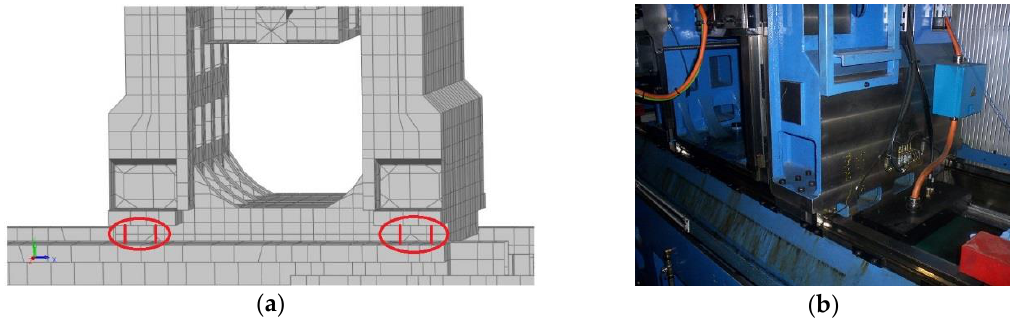
Figure 4. Connections between bed frame and column in a ( a ) FE model and ( b ) photograph.